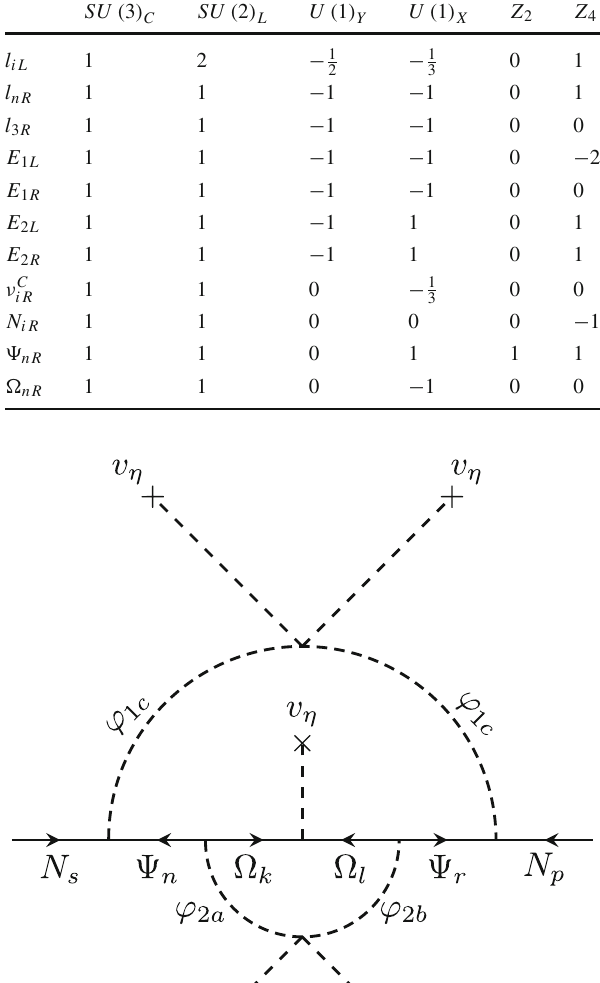
Table 1 Scalar assignments under SU ( 3 ) C × SU ( 2 ) L × U ( 1 ) Y ×